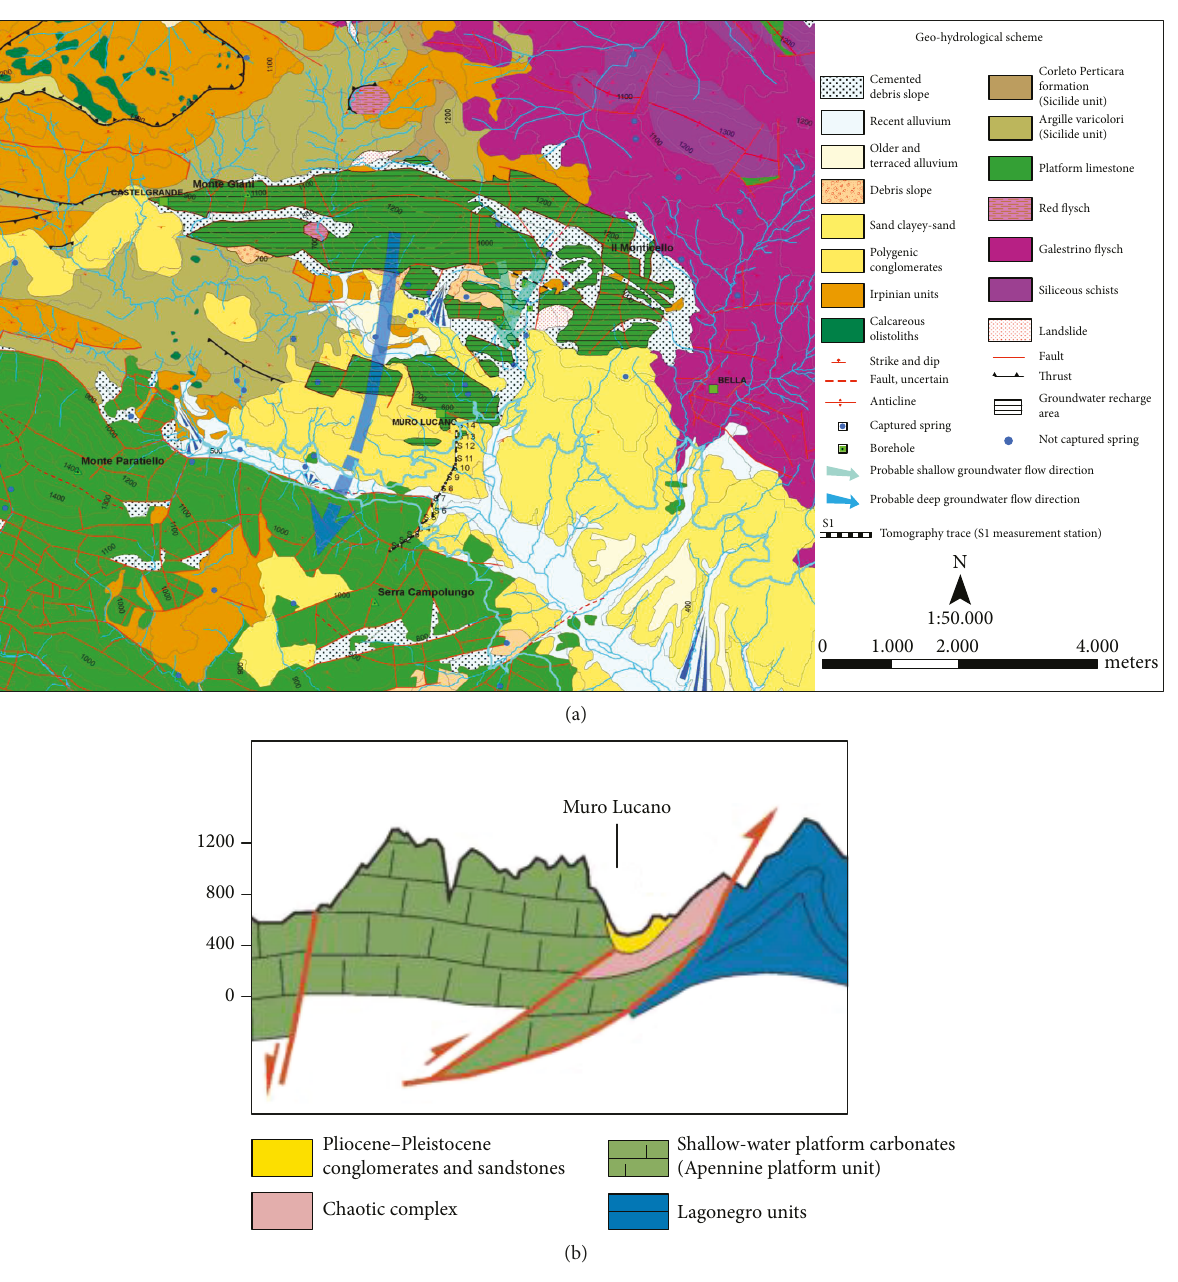
Figure 2: (a) Geological map with hydrogeological features. (b) Cross-section of the shallow geological structures along the Crop 04 deep seismic pro fi le from San Gregorio Magno to San Fele. Modi fi ed by Scandone et al.